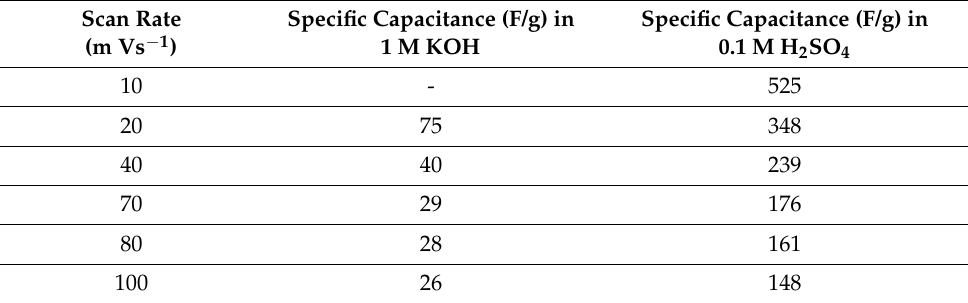
Table 3. Specific capacitance measurements from cyclic voltametric measurements.